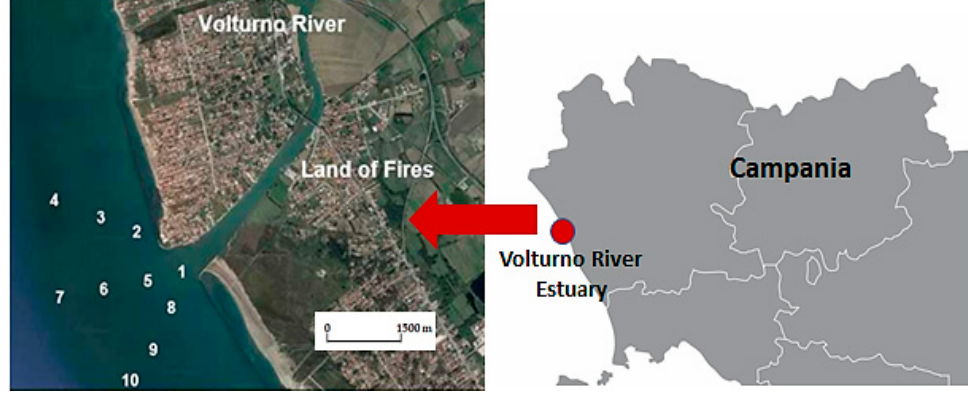
Figure 4. Hydrographic network and sampling sites near the Volturno River. Table 3. Sampling sites with their identification number (ID), location name, and coordinates from the Volturno